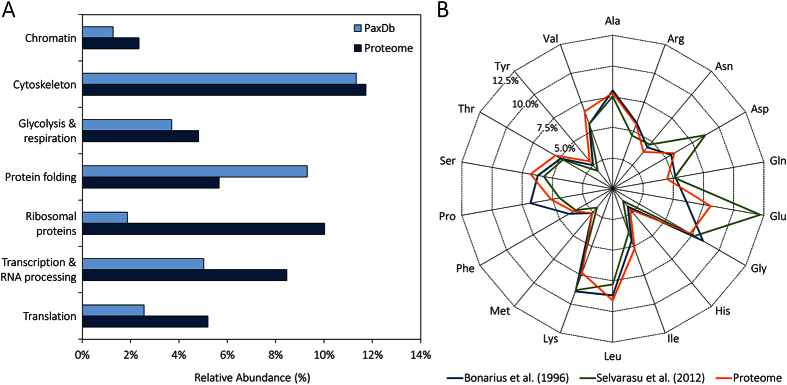
Relative abundance and amino acid composition of CHO host cell proteins.The relative abundance of the major categories for CHO HCPs are compared with those obtained from murine ovary cells4950 (A). The amino acid composition of murine38 and CHO51 host cell proteins used in previous studies is compared with the one estimated from the CHO proteome (B).